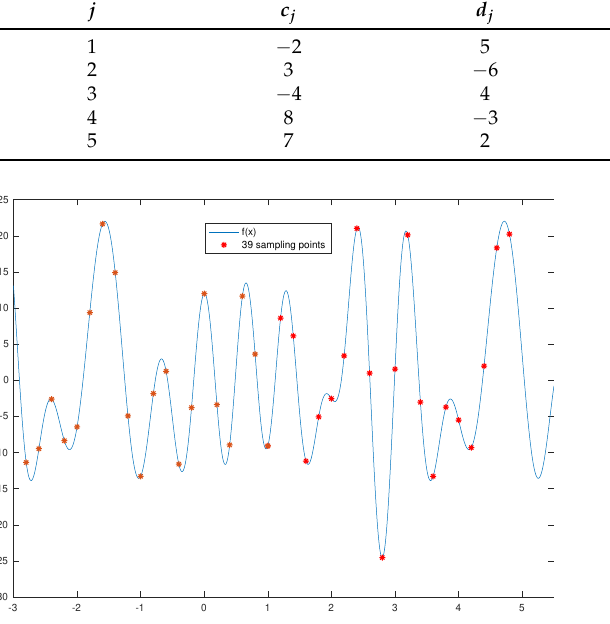
Figure 1. The signal f ( x ) in ( 58 ) with 39 equispaced sampling